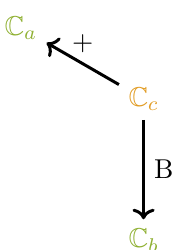
Figure 32. Representation for resolving by a 2:1 strand.